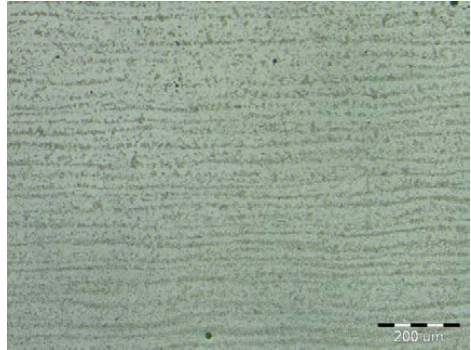
Figure 6. Banded fine-grained microstructure of a base material.